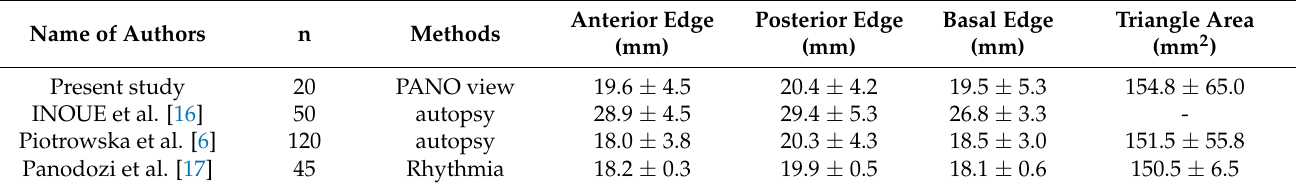
Table 4. Comparisons of the triangle of Koch between the present study and previous